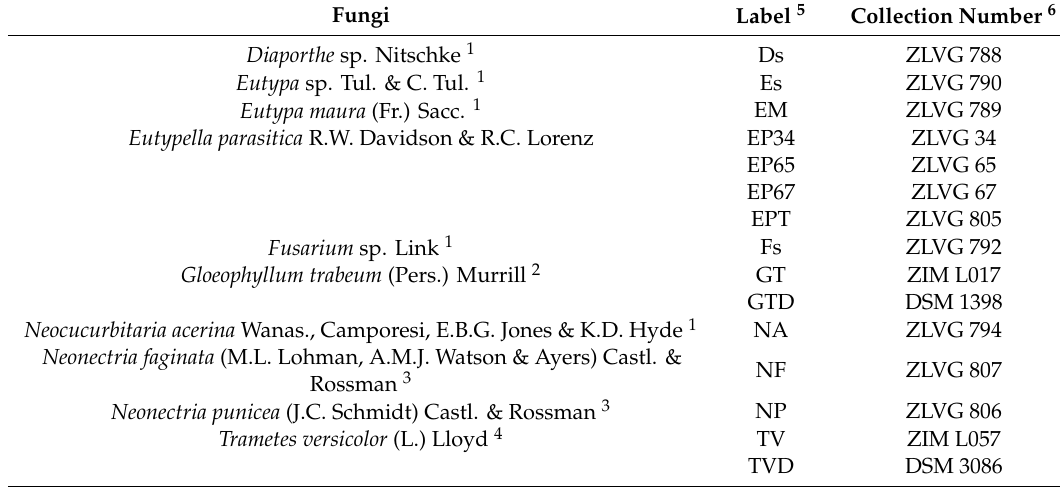
Table 1. Wood decay fungi used in decay